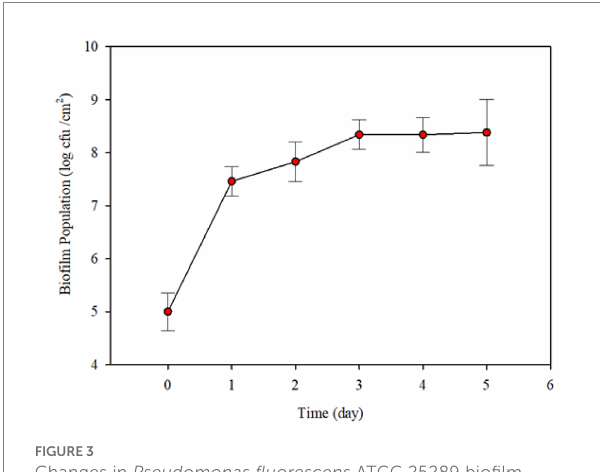
FIGURE 3 Changes in Pseudomonas fluorescens ATCC 25289 biofilm population formed on the interiors surfaces of small stainless- steel tubes (6.35 mm internal diameter, 19.05 mm long and internal surface area 3.78 cm 2 ), after incubation in 10% diluted skim milk under stagnant conditions, followed by circulating the contents of the contamination loop at 1.5–2.0 L/h and simultaneous feeding fresh diluted skim milk at 125 mL/h. Each error bar represents ± standard